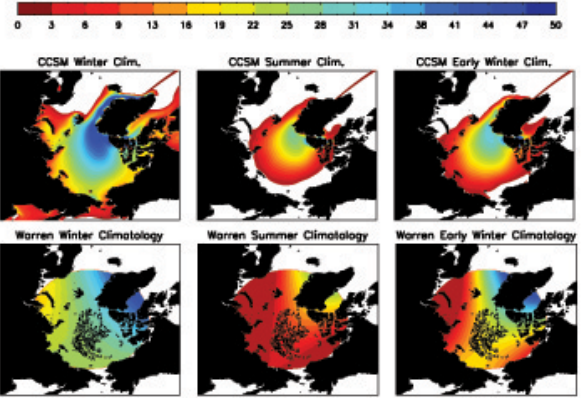
Fig. 2. Geographical distribution of modeled snow depth and in situ measurements, in cm. As defined by the color bar, red corresponds to low snow depth and blue to high snow depth. From left to right: winter (January, February, March), summer (June, July, August), and freeze-up (October). The top row is the CCSM ensemble snow depth climatology. The second row overlies the position of the Rus- sian drift station locations over a snow depth climatology derived from the in situ measurements taken at these stations (Warren et al., 1999).